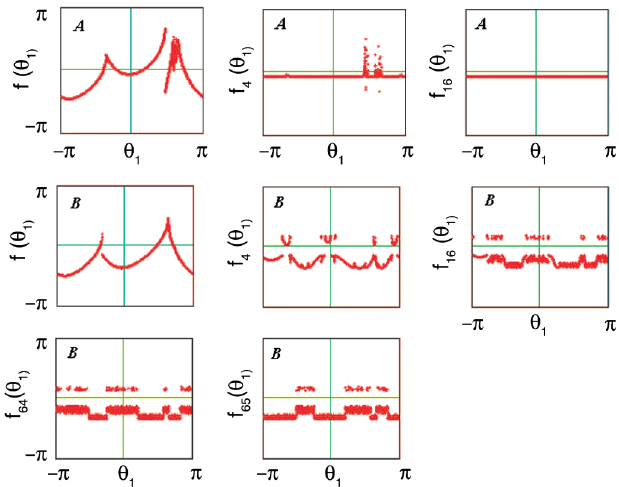
FIG. 8. Phase portrait of multipacting for points A and B of Fig. 1 after different number of